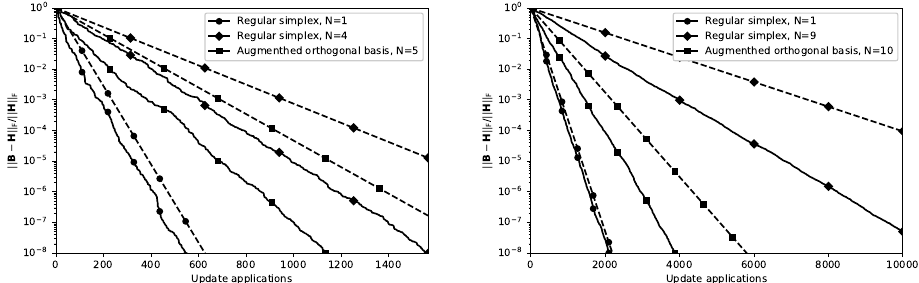
Figure 1. Progress of three simplicial updates for n = 5 ( left ) and n = 10 ( right ). Dashed lines represent the progress of the update assuming every update application improves the approximate Hessian by the amount predicted in Theorem